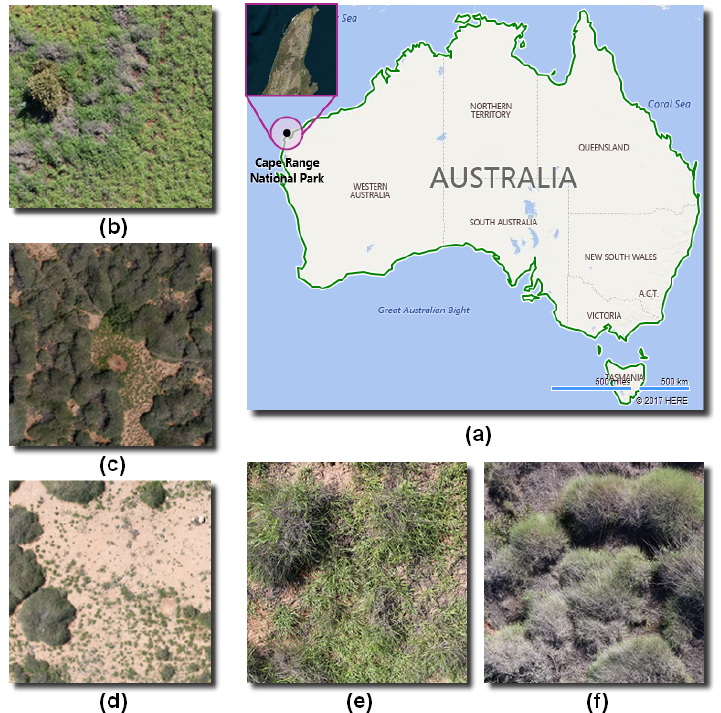
Figure 2. Main features of the study site. ( a ) Geographical location. ( b ) Area with high density of buffel grass. ( c ) Area with high density of spinifex. ( d ) Area with low density of invasive grasses. ( e ) Buffel grass. ( f )